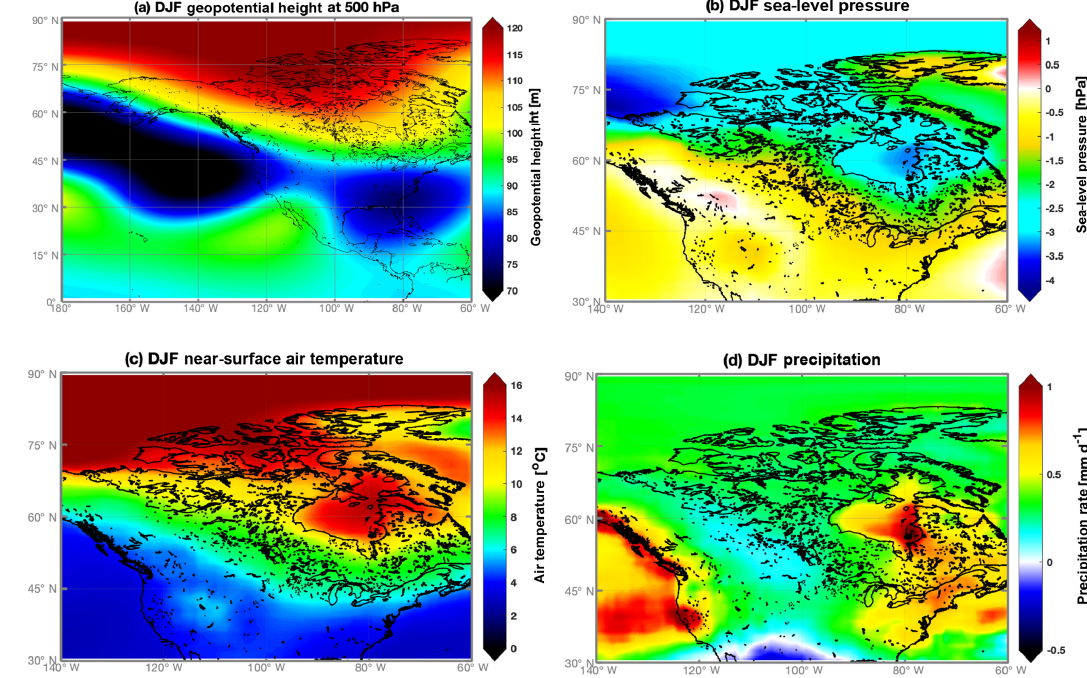
Figure 4. As in Fig. 2 but for winter